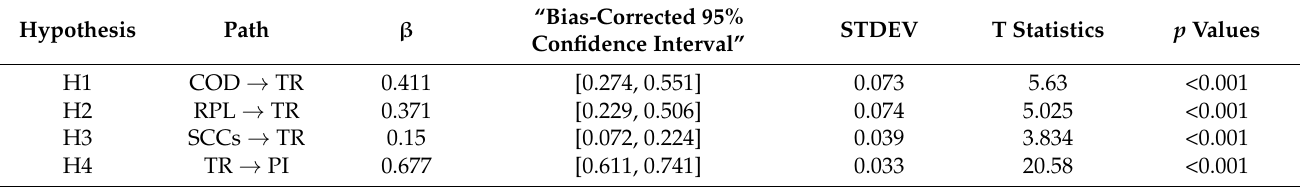
Table 6. Hypotheses